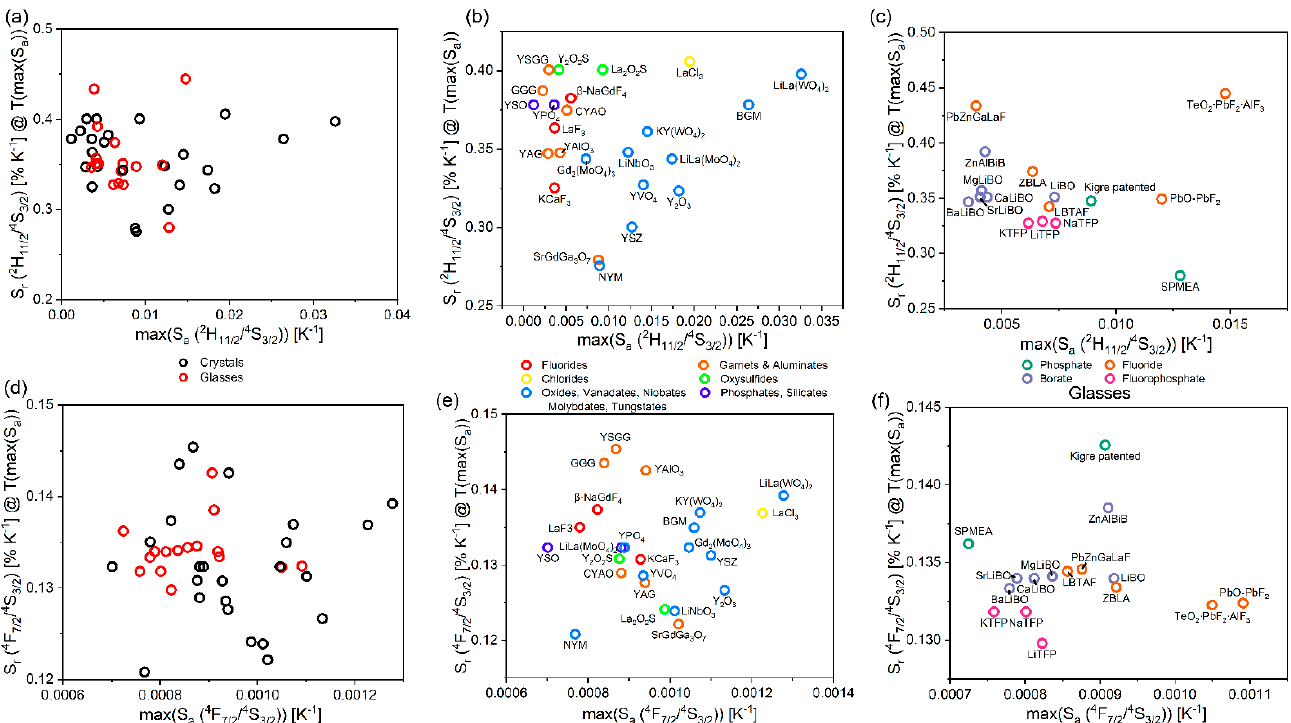
Figure 6. Relative sensitivities vs. absolute sensitivities at temperatures with maximum absolute sensitivities. ( a – c ) for LIR by 2 H 11/2 higher level, ( d – f ) by 4 F 7/2 . ( a , d ) comparison of crystals and classes, ( b , e ) between crystal types, ( c , f ) between different glasses.